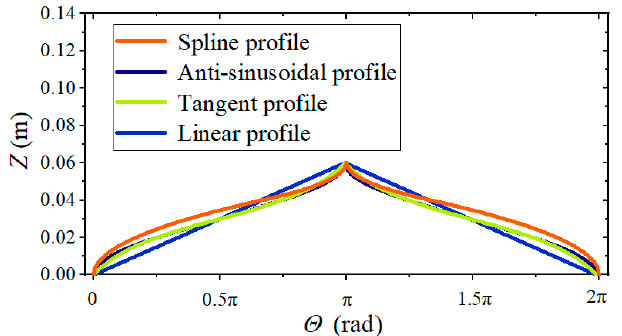
Figure 4. Cam groove profiles (CGPs) circumferential expanded view.